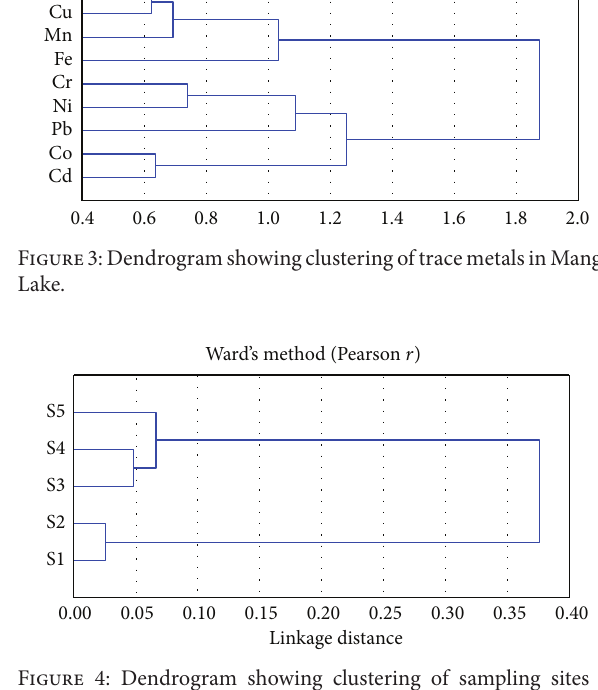
Table 4: Principal component loadings ∗ for trace metals in surface water of Mangla Lake.